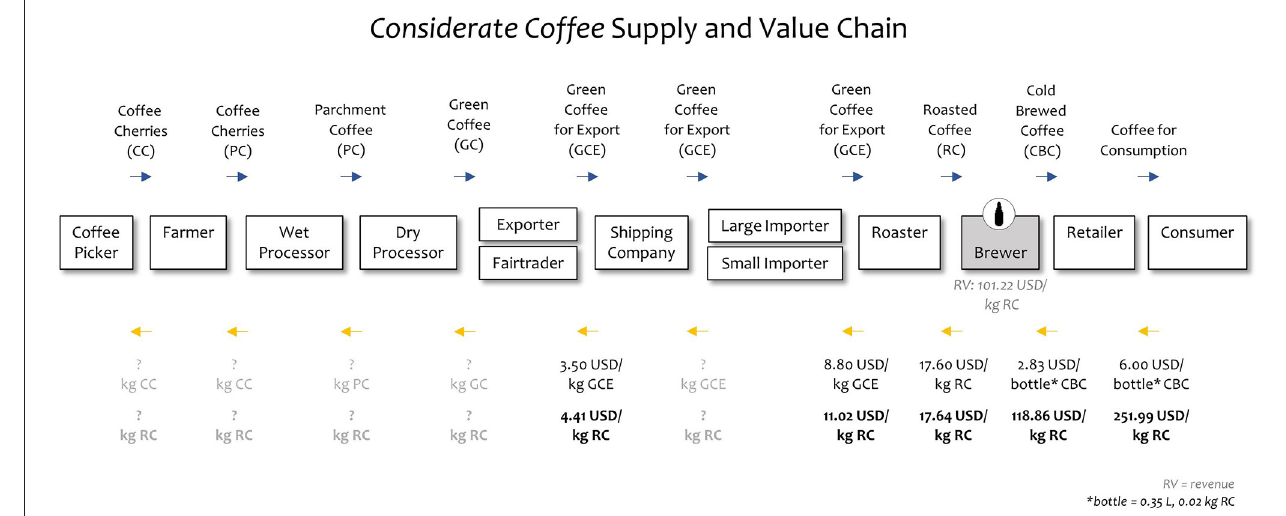
FIGURE 1 | Prior supply and value chain of Considerate Coffee.